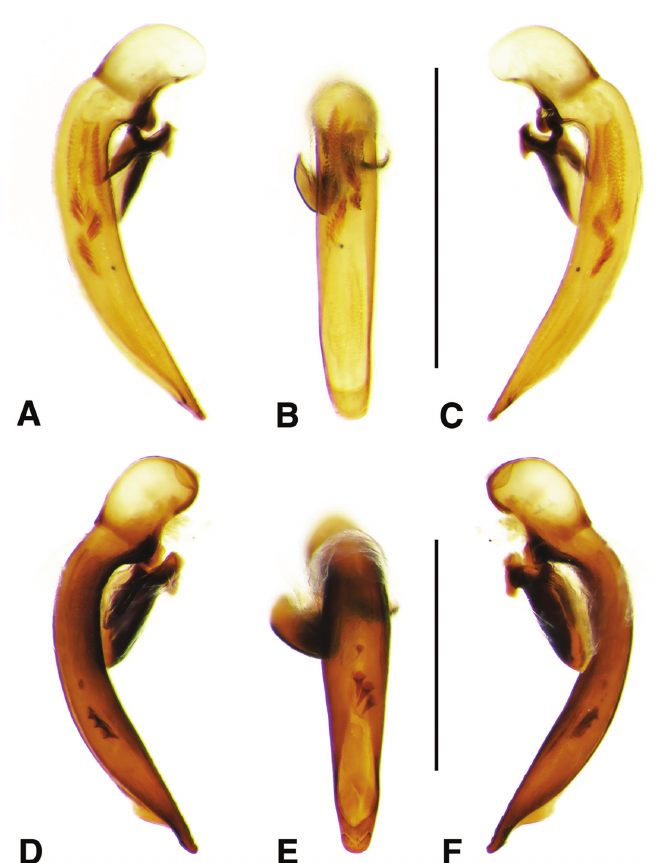
Figure 27. Digital images of male genitalia of Selenophorus hylacis species group, in part. A, D right lateral aspect B, E dorsal aspect C, F left lateral aspect A–C S. clypealis Ball & Shpeley D–F S. dessalinesi Ball & Shpeley. Scale bars 1